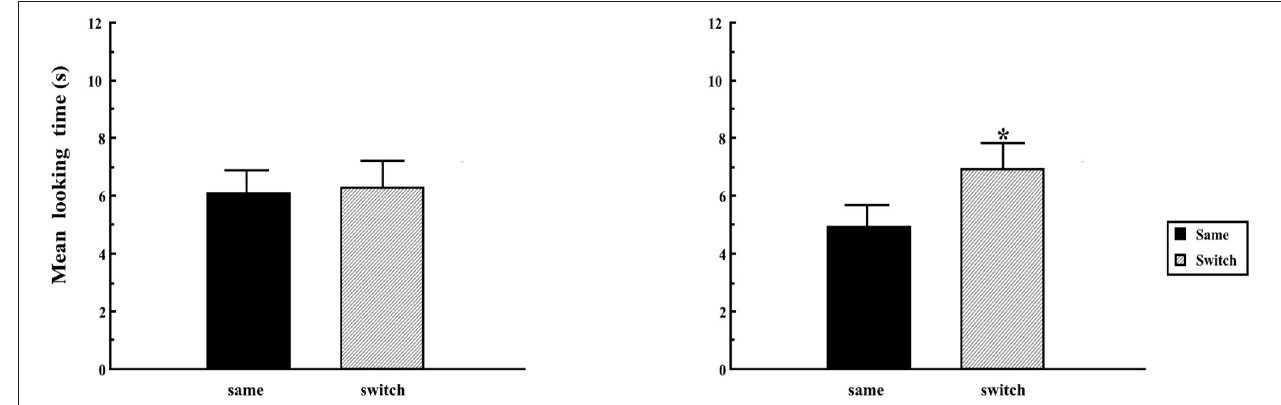
FIGURE 4 | Experimental results from Rost and McMurray (2009): 14 month-old infants do not have significantly longer looking time to the labeled object on switch trials after exposure to a single speaker (left) but they do after exposure to multiple speakers (right) . The asterisk indicates a statistically significant increase in looking on the switch trials compared to the same trials.